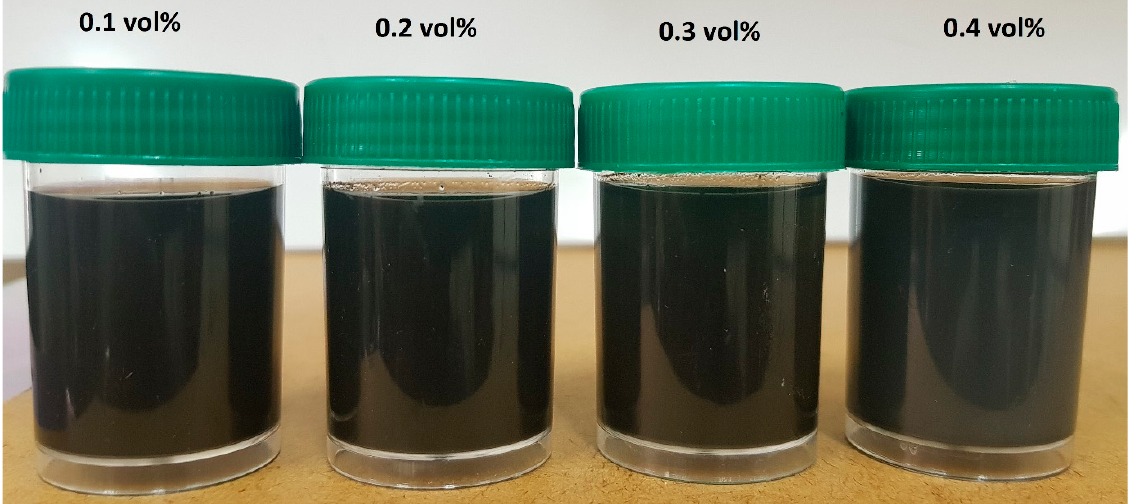
Figure 3. Photographs of the hybrid nanofluids 4 days after preparation.